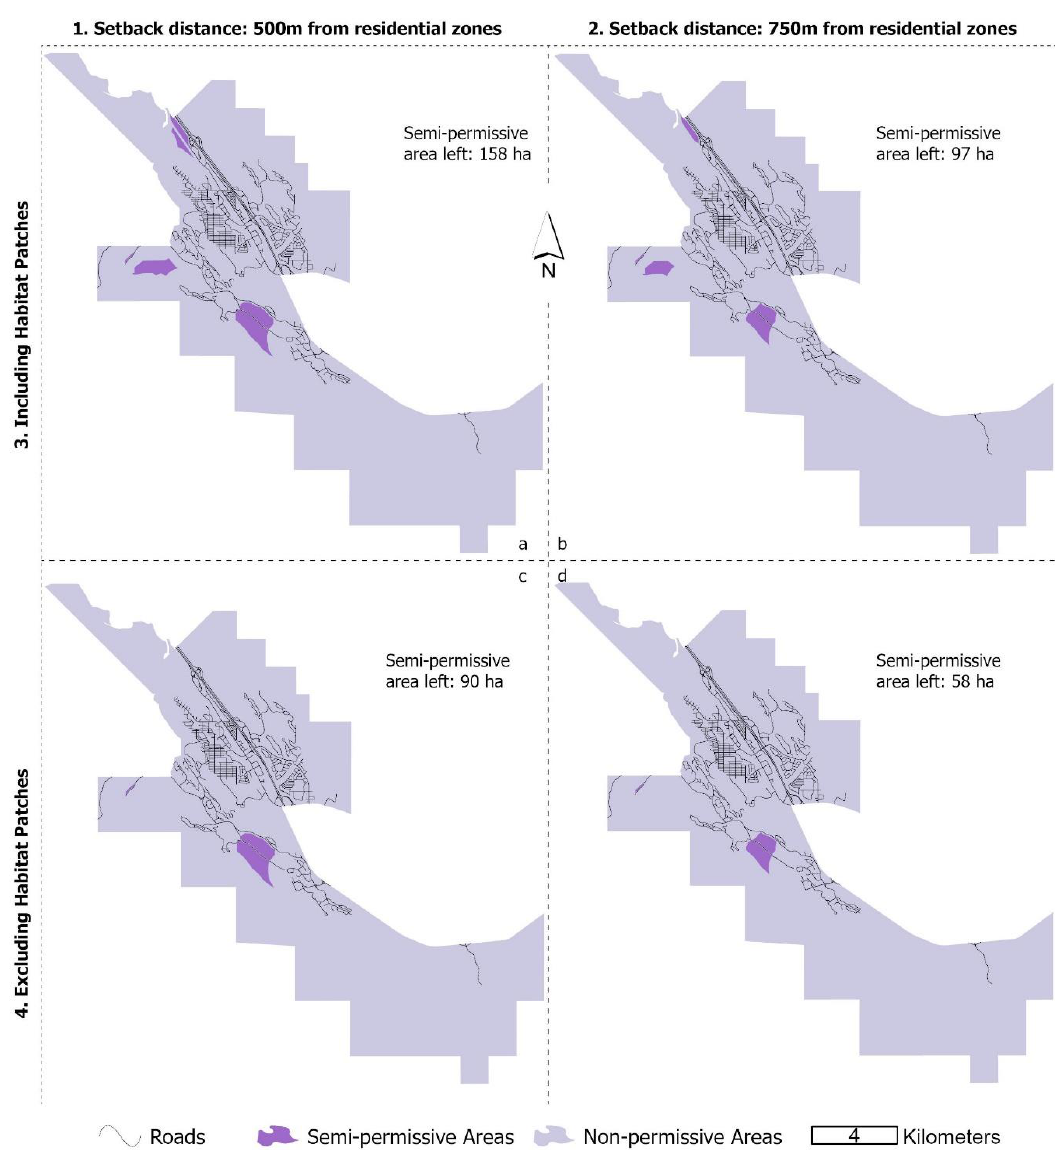
Figure 8. Four wind development scenarios are ( a ) applying 500 m setback distance from residential zones; ( b ) applying 750 m setback distance from residential zones; ( c ) applying 500 m setback distance and excluding habitat patches; and ( d ) applying 750 m setback distance and excluding habitat patches.